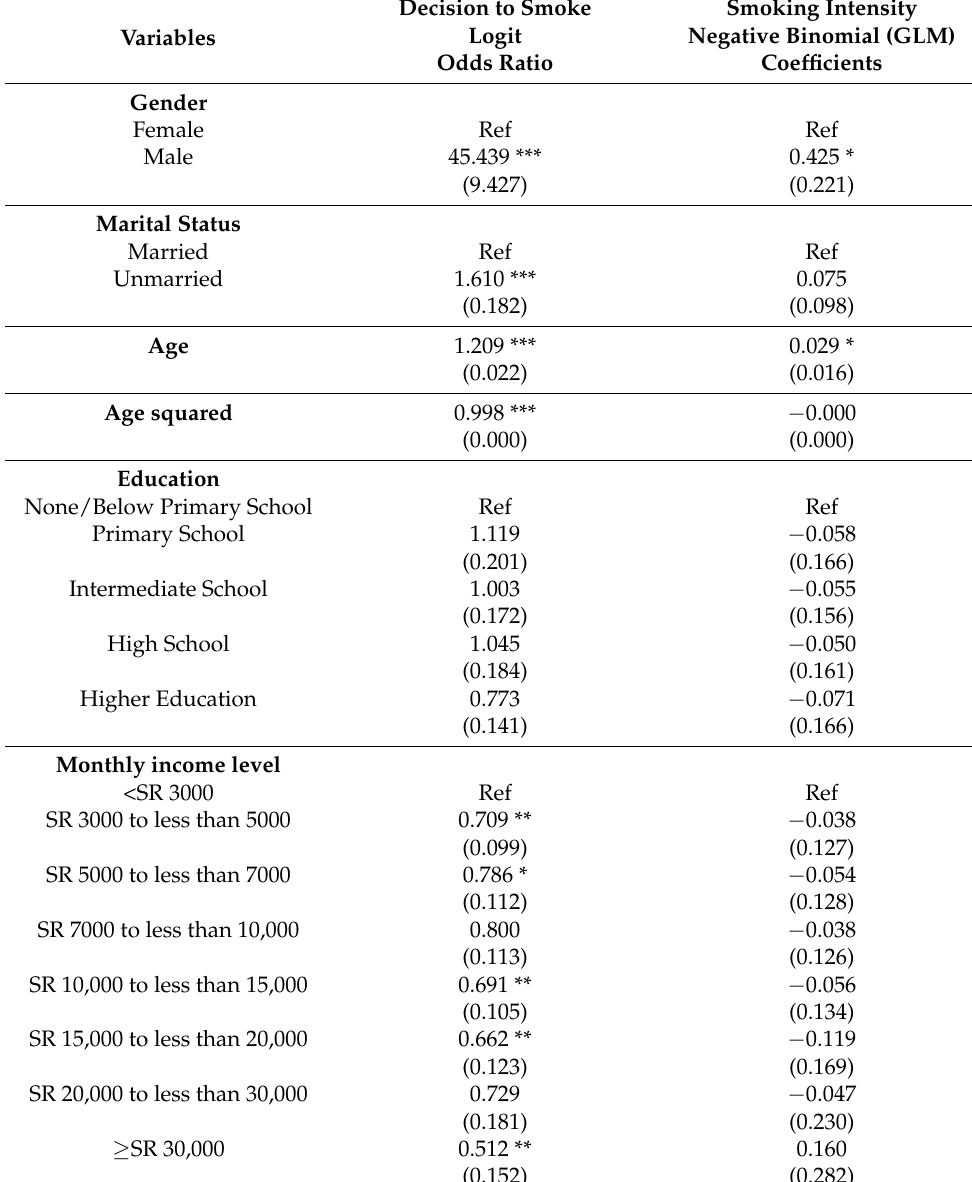
Table A1. Socioeconomic determinants of smoking and smoking intensity using a two-part